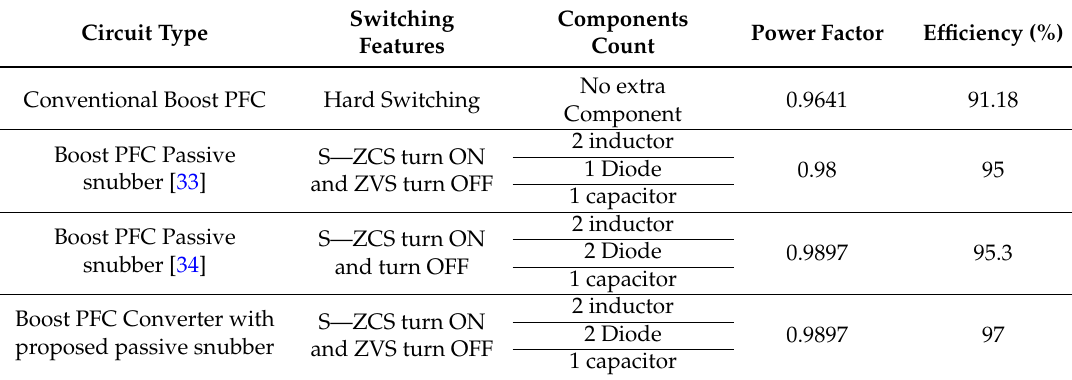
Figure 11. Input voltage and efficiency and duty cycle. Table 2. Performance comparison of the proposed PFC converter and the conventional PFC converters.